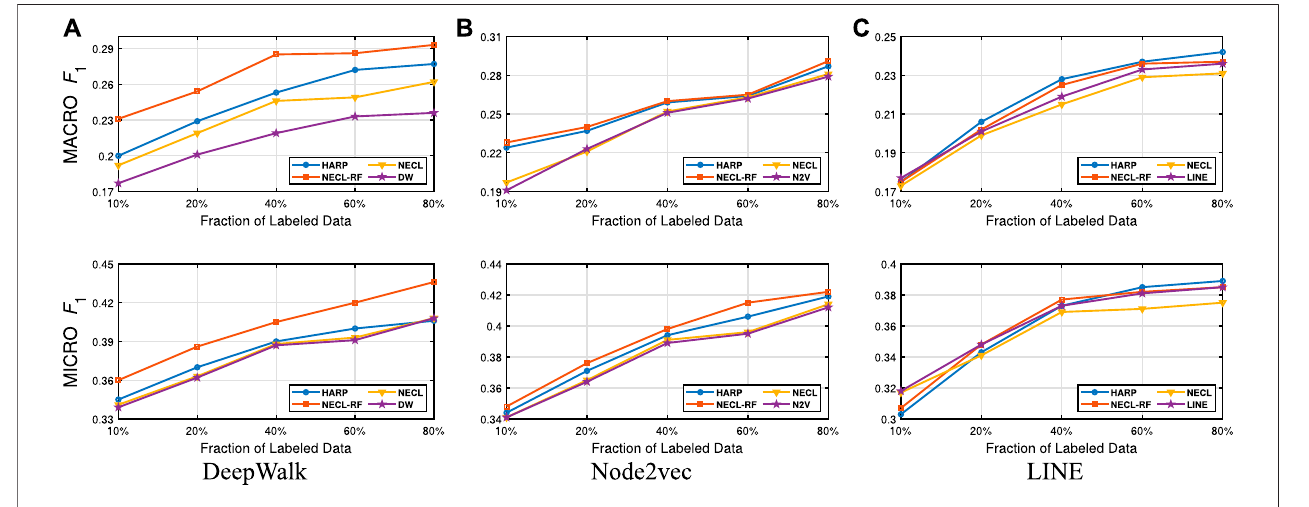
FIGURE 12 | Detailed comparisons of classi fi cation results on